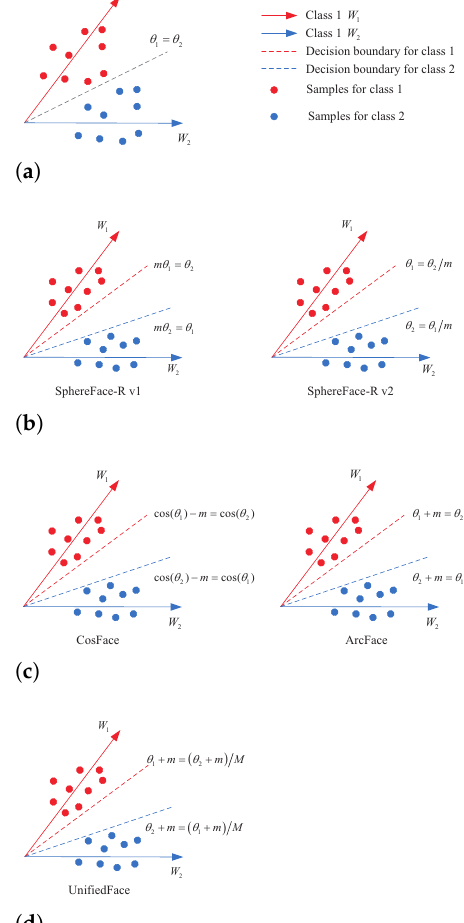
Figure 5. ( a ) No angular margin; ( b ) is the multiplicative margin; ( c ) is the additive margin; ( d ) is the uniform angular margin.